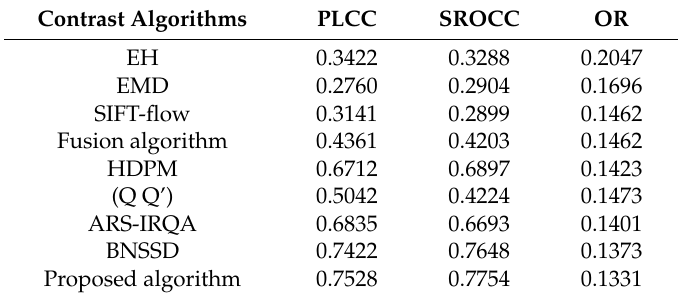
Table 2. Comparison of the proposed method with other methods in database